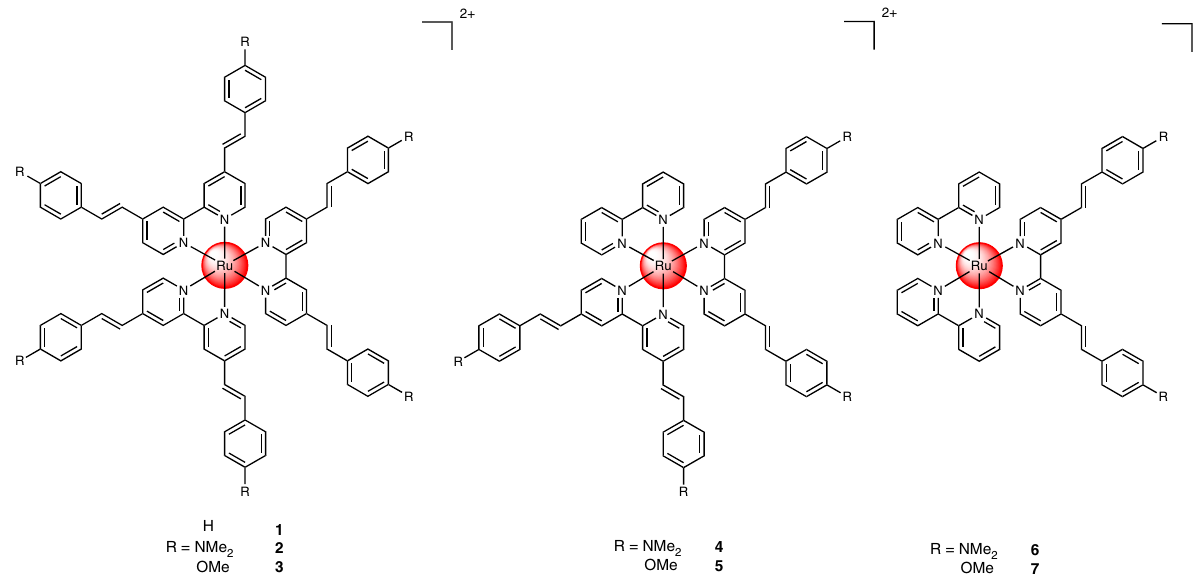
Fig. 1 Chemical structures of complexes 1 – 7 investigated in this study. The complexes were isolated as hexa fl uorophosphate